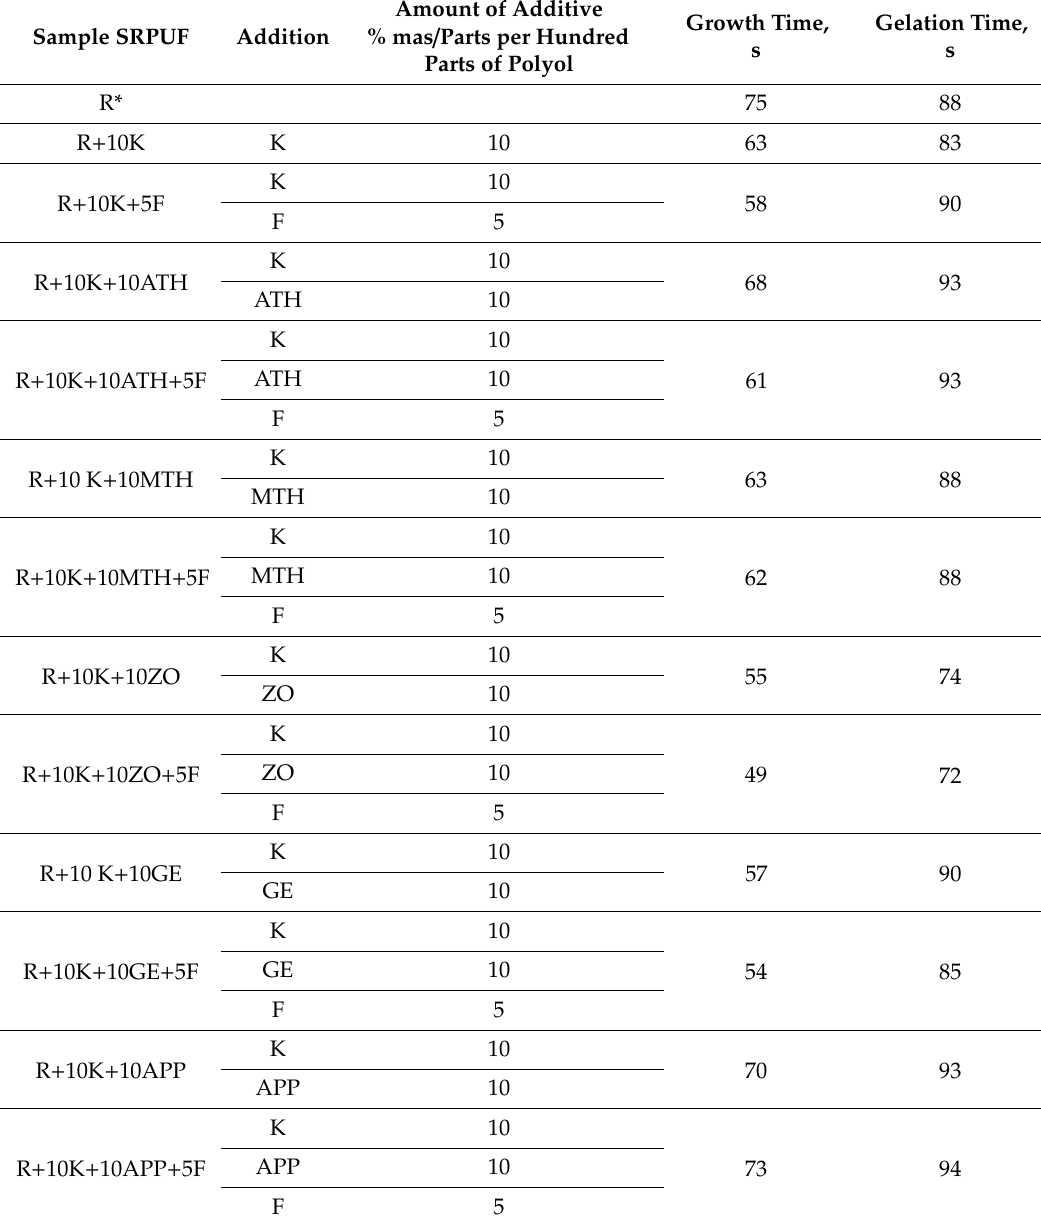
Table 1. The composition of semi-rigid polyurethane foams (SRPUR) and synthesis.